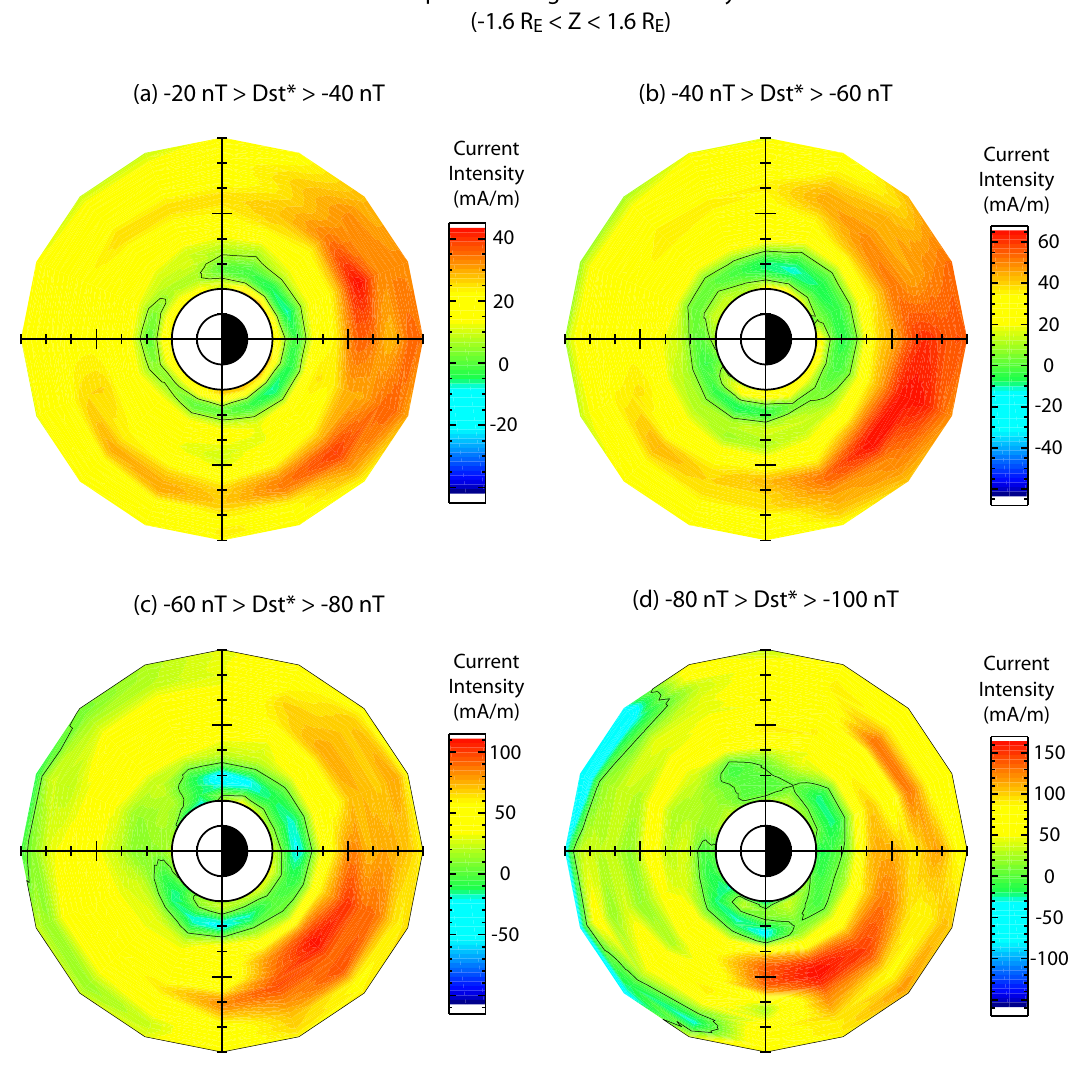
Fig. 7. Equatorial ring current intensity as a function of magnetic local time and distance from the dipole axis for each of the four D st * levels. The current intensity is calculated by integrating the azimuthal component of the current density over − 1 . 6 <Z< 1 . 6 R E . The color bar is linear and differs for each